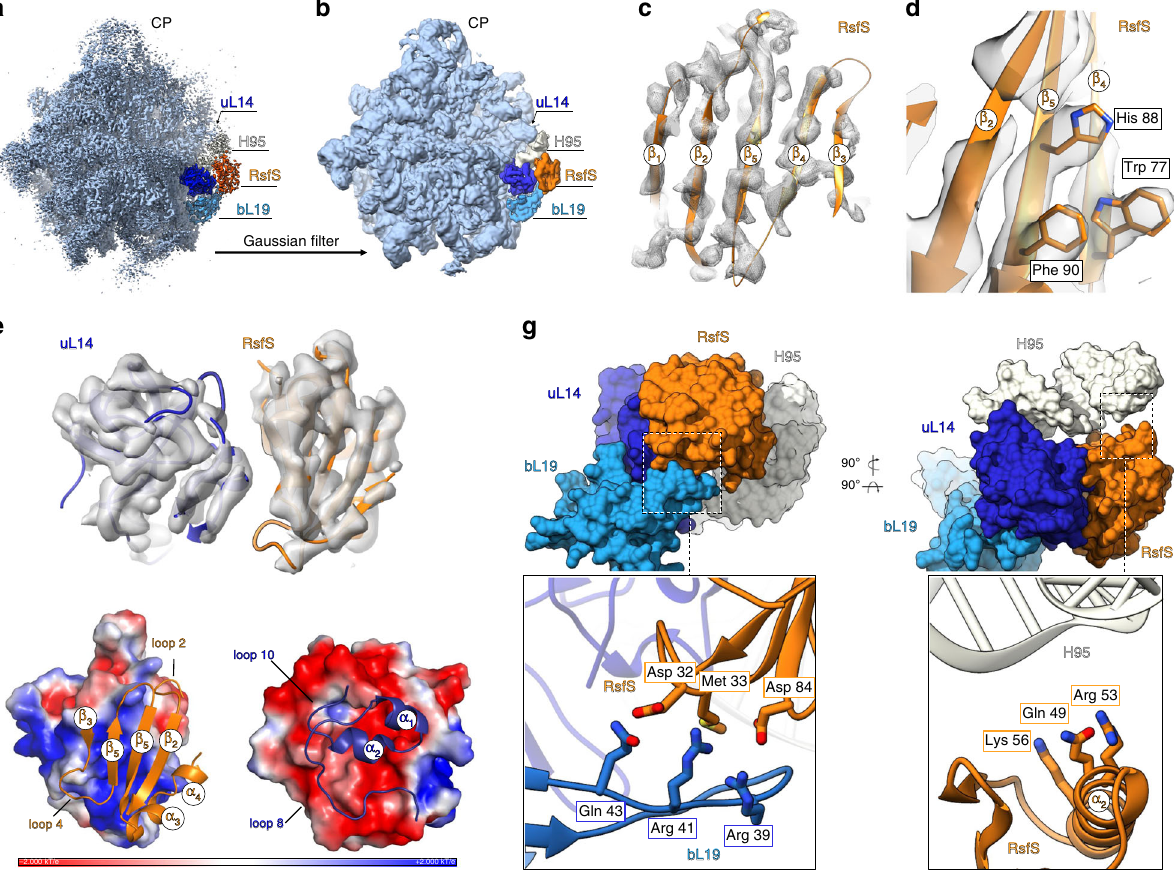
Fig. 2 Cryo-EM reconstruction of the 50S – RsfS complex and model interpretation. a The 3.2 Å cryo-EM density map. Ribosomal protein uL14 is colored in dark blue, bL19 in bright blue, 23S rRNA Helix 95 in white, and RsfS in orange. CP central protuberance. b A low-pass fi ltered map of the 50S – RsfS complex (Gaussian fi lter with the width equal to 3.5 voxel size of the initial map) was used for the initial fl exible fi tting of the molecular model. c , d Density corresponding to the RsfS beta-sheet assembly and model is fi tting. For representation reasons, a Gaussian fi lter with the width equal to one voxel size (outer mesh) was applied to the initial cryo-EM map (inner mesh). e The uL14 – RsfS interaction interface as seen in the cryo-EM map (a Gaussian fi lter with the width equal to 1.5 voxel size applied). f Electrostatic potential of uL14 and RsfS (surface representation) calculated from the model; the structural elements involved in contacts formation are shown as ribbons and labeled. g The RsfS-binding cavity, including uL14, bL19, and H95. Molecules are shown in surface representation. Close-up sections demonstrate potential interacting residues of the proteins (represented as